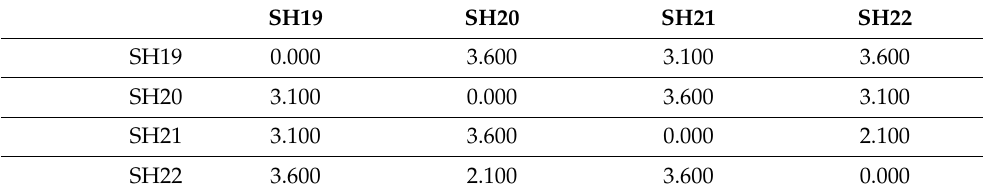
Table 7. Crisp direct-relation matrix Z 1 —human talent sub-criteria.